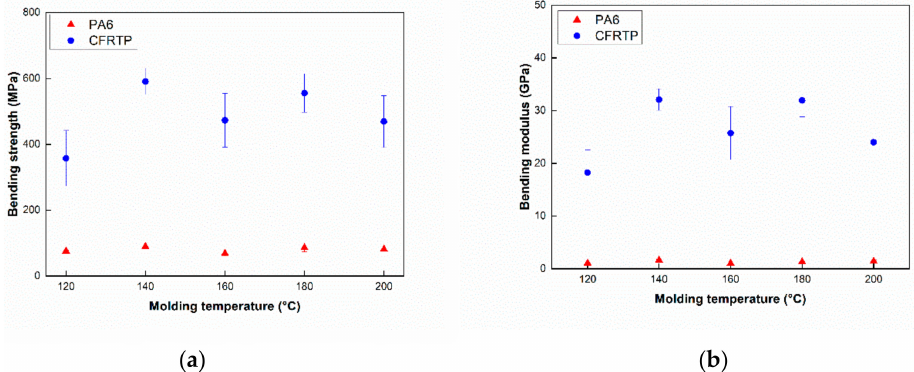
Figure 5. Bending strength ( a ) and modulus ( b ) of the pure PA6 and CFRTP composites at di ff erent molding temperatures.